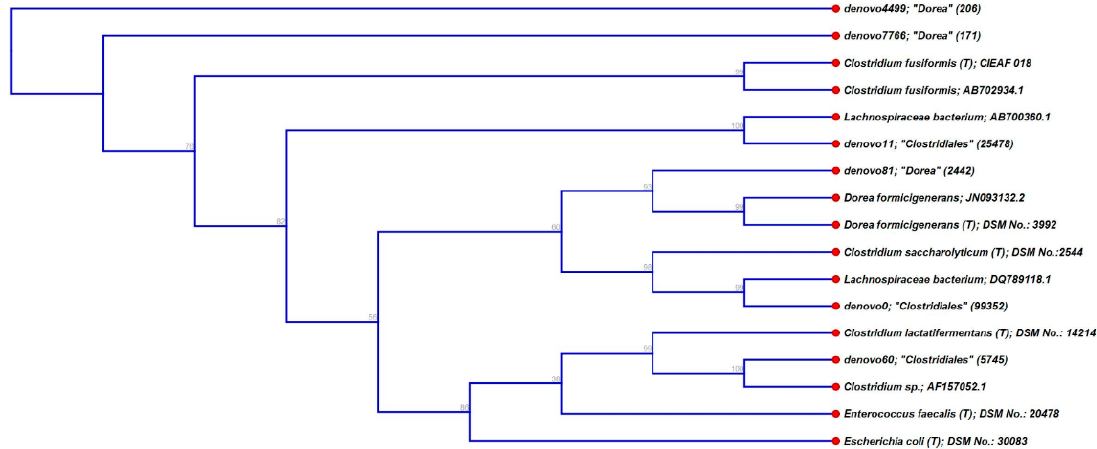
Figure 4. Dendrogram showing the relatedness of the three most abundant OTUs of the bacterial taxa that differed significantly ( p ≤ 0.05) between ‘light’ and ‘heavy’ RNA fractions (i.e., unclassified Clostridiales and Dorea spp.) to their next cultured relatives according to a BLAST search. Escherichia coli and Enterococcus faecalis were used as outgroups.